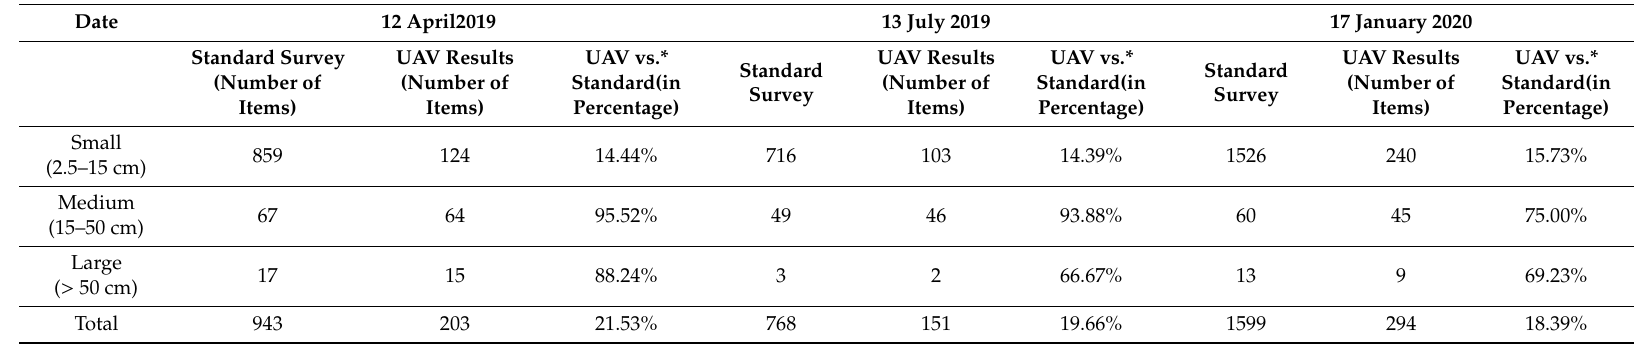
Table 2. Results from a manual standard survey of the studied beach, compared with the one obtained from ortho-mosaic (dimensional